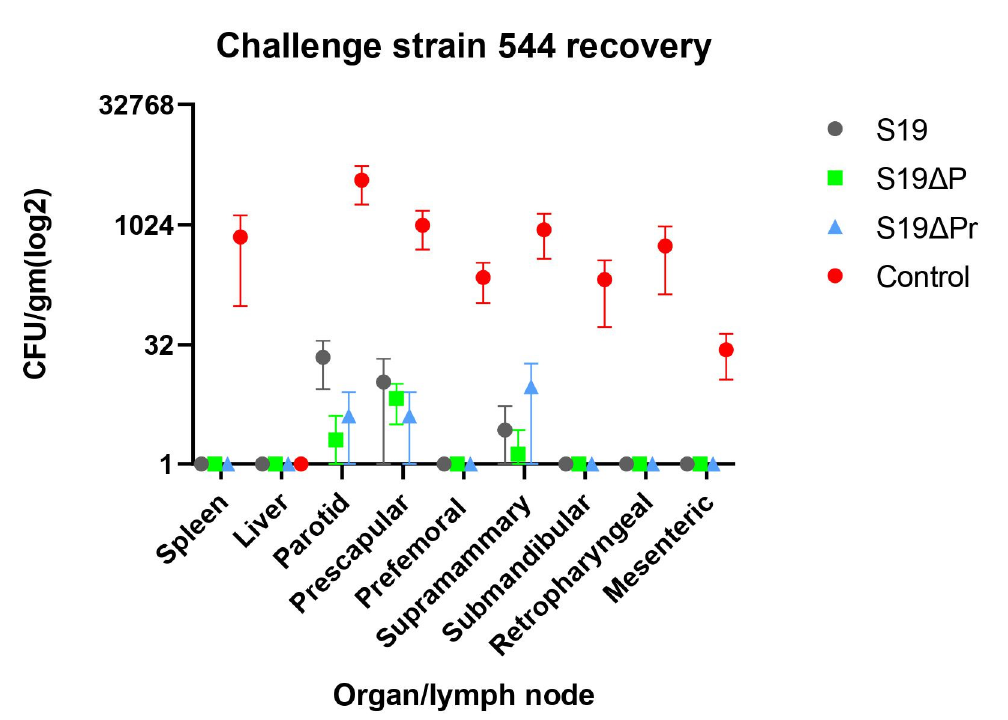
Figure 8. Post-challenge load of bacterial infection in organs and lymph nodes of buffaloes. Non-immunized control animals showed heavy Brucella burden in various organs, except livers. The animals immunized with candidate vaccine, S19 ∆ per and S19 ∆ per reduced dose, showed reduction in Brucella burden, which is comparable to standard S19 vaccine. Compared to non-immunized control group, a significant reduction in the Brucella count was observed in S19, S19 ∆ per and S19 ∆ per reduced dose groups. Within the immunized groups, the bacterial counts in different organs were not significantly different.